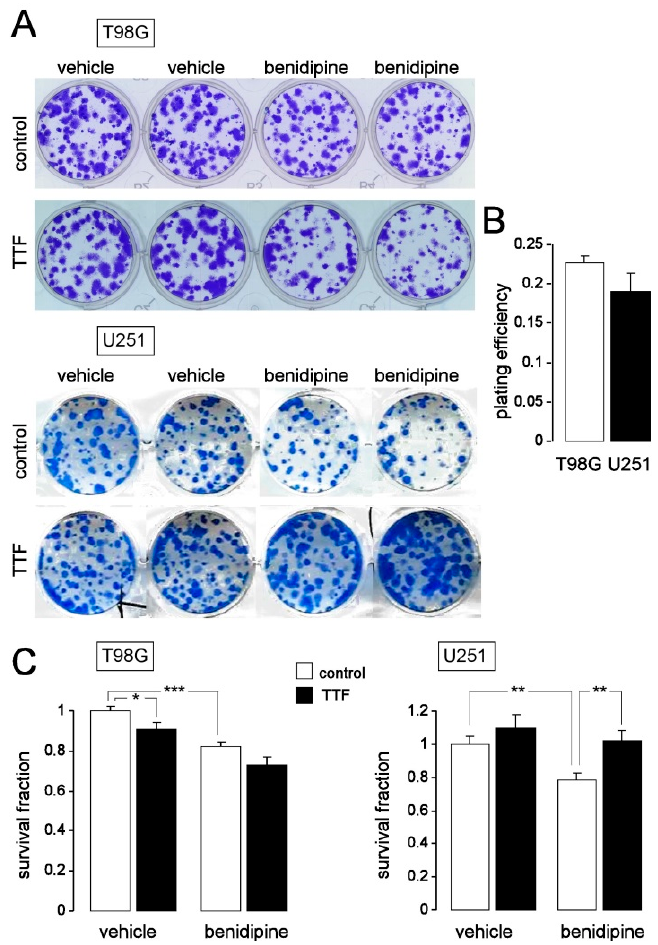
Figure 9. TTFields reduce clonogenic survival of T98G but not of U251 cells. ( A ) Pre-plating colony formation of T98G (top) and U251 (bottom) cells after treatment with 0 V/m (control) or 1 V/m TTFields field strength and co-incubation with vehicle alone or benidipine (1 µ M) for 7 days. Shown are cut-outs of 6-well plates with Coomassie-stained T98G (top) and U251 (bottom) colonies. ( B ) Mean ( ± SE, n = 16–22) plating efficiency of T98G and U251 cells. ( C ) Mean ( ± SE, n = 16–24) survival fractions of T98G (left) and U251 cells (right) after treatment with 0 V/m (control) or 1 V/m TTFields strength and co-incubation with vehicle alone or benidipine (3 µ M) for 7 days. Data were obtained by pre-plating colony formation assay as shown in ( A ). *, ** and *** indicate 3 p ≤ 0.05, 3 p ≤ 0.01, and 3 p ≤ 0.001, respectively, Welch-corrected t -test and Bonferroni correction for three pairwise comparisons (vehicle/control vs. benidipine/control, vehicle/control vs. vehicle/TTFields, and benidipine/control vs. benidipine/TTFields).